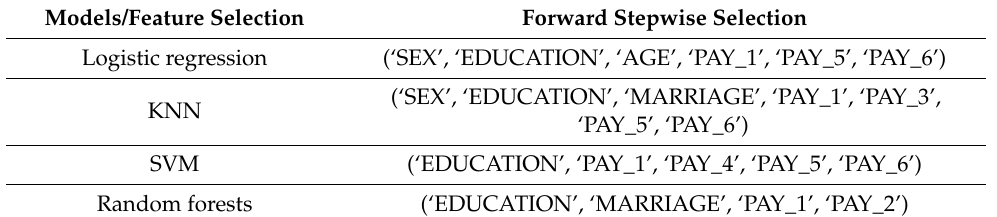
Table 5. The features selected by forward stepwise method.